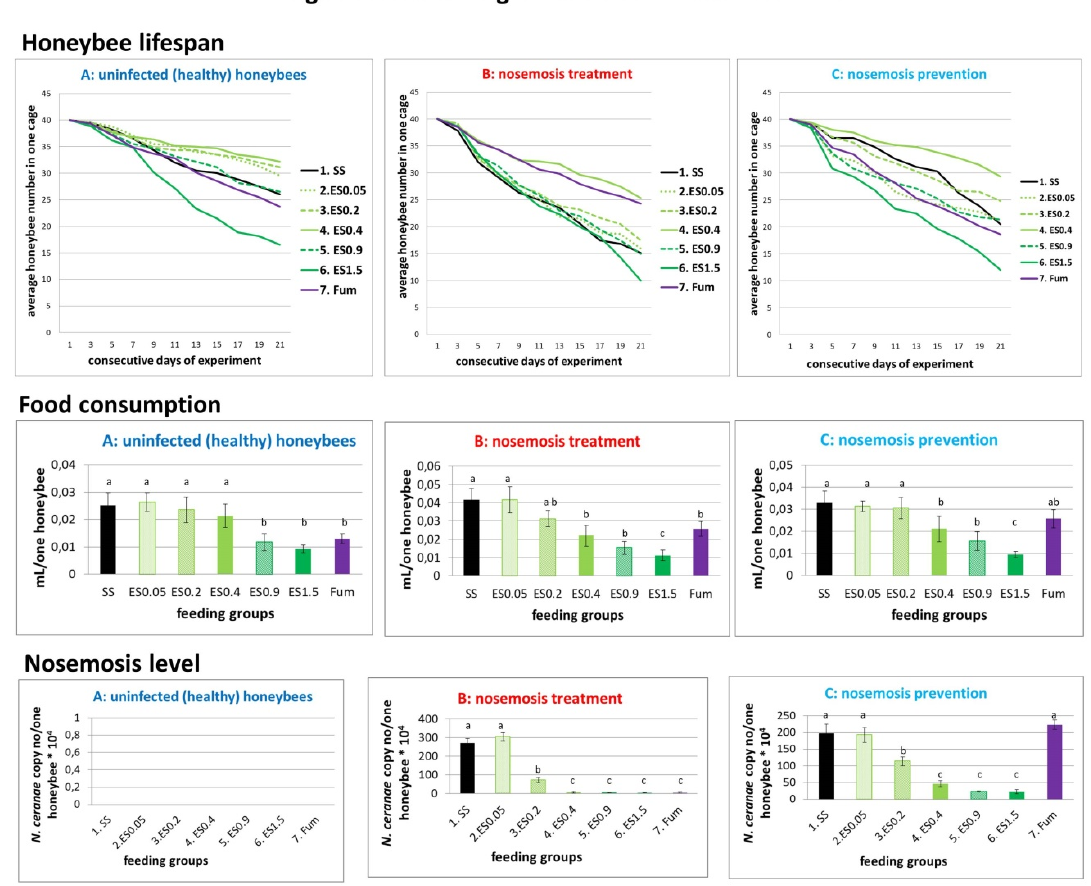
Figure 3. Results of cage tests: Screening for the best Eleutherococcus dose. Data illustrated honeybee lifespan, food consumption and the level of nosemosis in all three variants of conducted experiments, i.e., ( A ) uninfected honeybees, ( B ) treatment of nosemosis and ( C ) prevention of nosemosis were compared. Lowercase letters (a,b,c) indicate significant differences between the group fed with pure sucrose syrup without extracts (SS) and the groups fed with additions of extracts (at least p ≤ 0.05 for the honeybee lifespan, p ≤ 0.05 for food consumption and p ≤ 0.01 for level of nosemosis) (ANOVA, Tukey test). Error bars denote a confidence interval (CI). Feeding groups: E. senticosus ethanol root extract was added to the sucrose solution to the final concentrations of 0.05 mg / mL, 0.2 mg / mL,